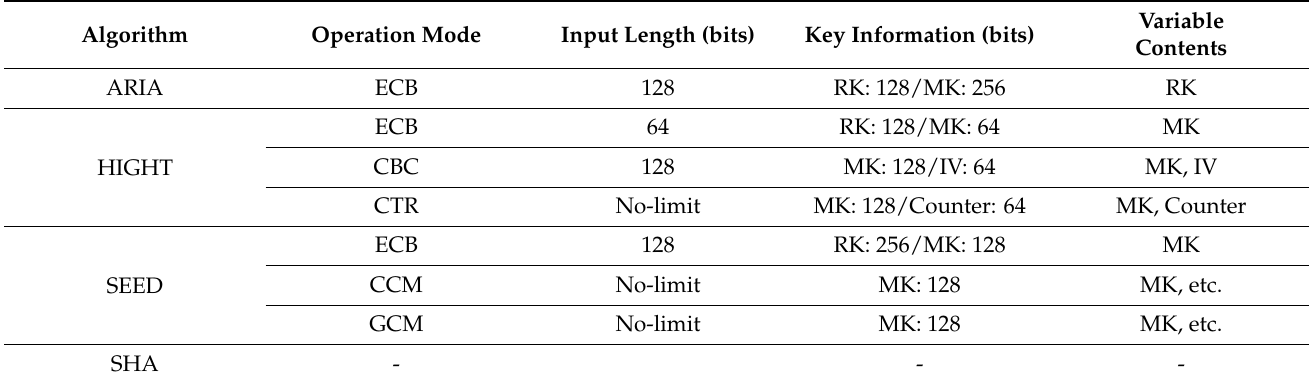
Figure 3. Photographs of ( a ) the developed security module and ( b ) the evaluation setup. Table 1. Possible encryption types and key information for the security